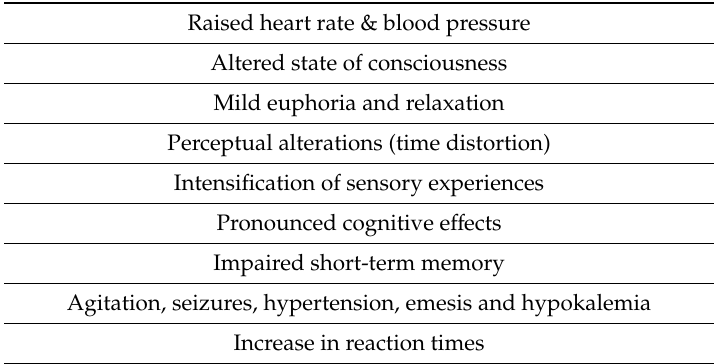
Table 2. Some known physiological e ff ects of synthetic cannabinoids (SCBs)